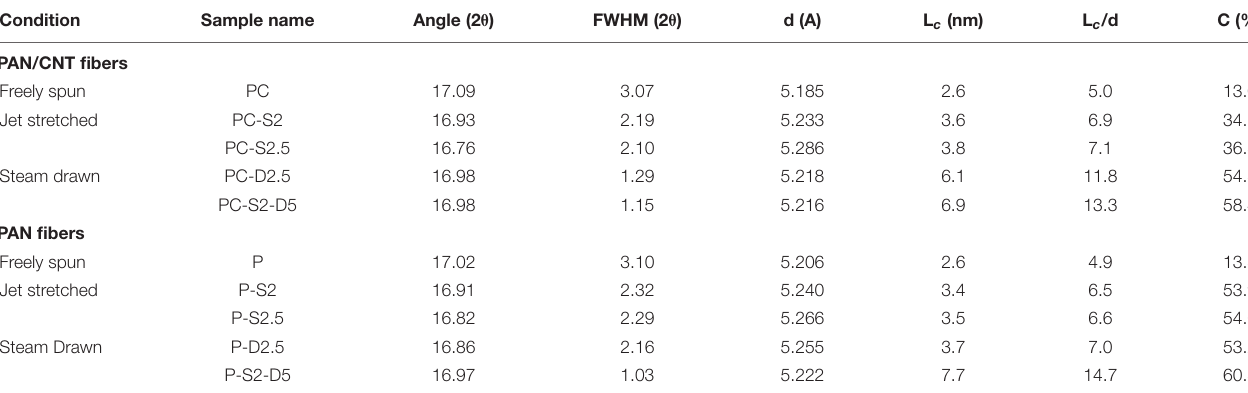
TABLE 3 | Parameters of crystalline structure of PAN/CNT and PAN fibers at different stretching conditions.